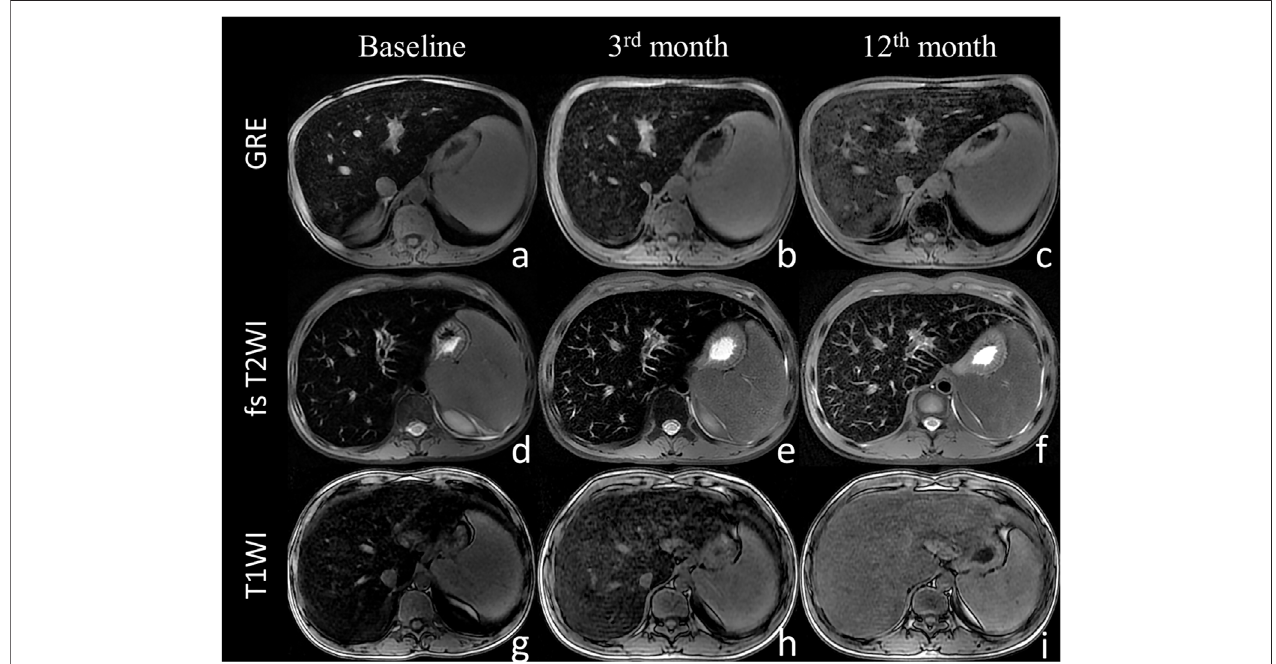
FIGURE 2 | The liver magnetic resonance imaging signal intensity with the sequence of gradient echo (A – C) , fast spin echo sequence T2-weighted imaging (D – F) and T1-weighted imaging (G – I) atbaseline (A,D,G) ,3 months (B,E,H) ,and12 months (C,F,I) .TheliverMRIsignalintensityincreasedwiththalidomidetreatment during the 12 months of follow up.